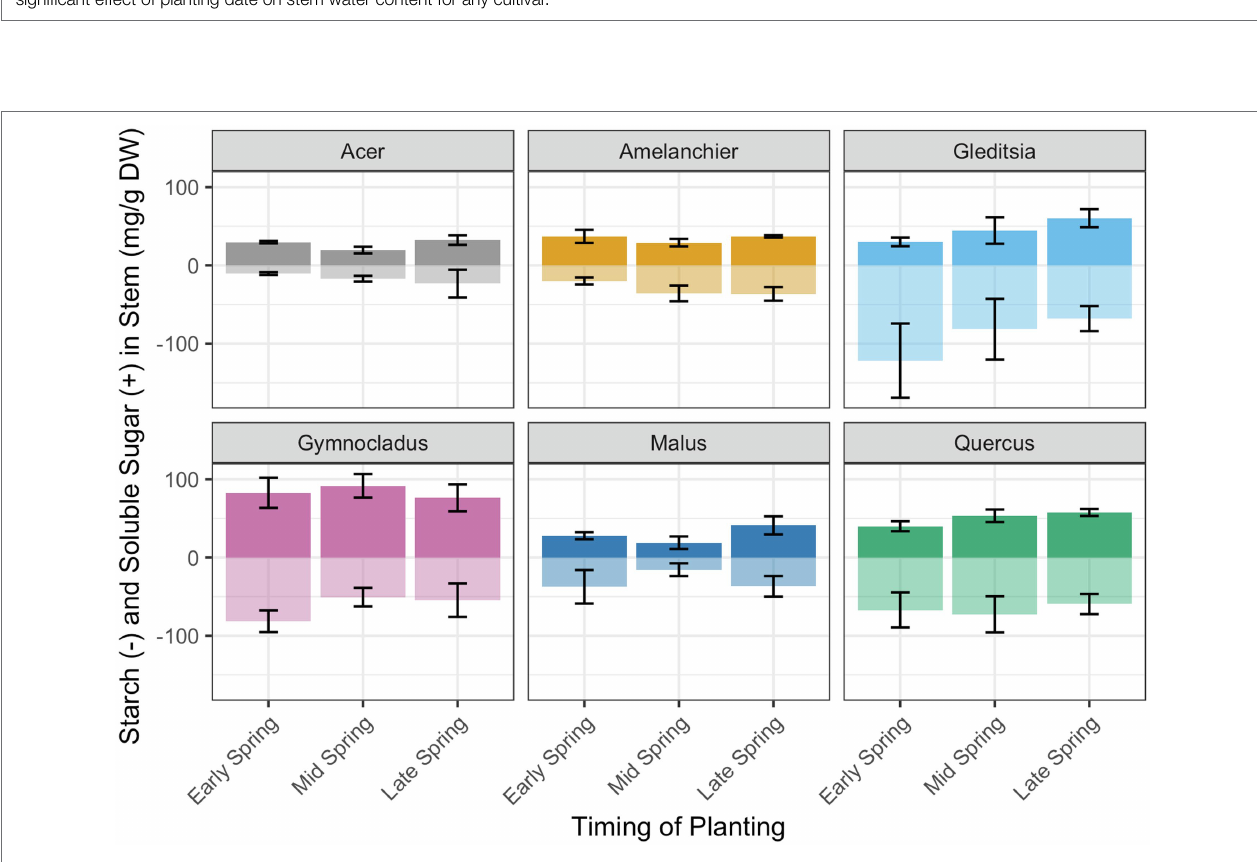
FIGURE 4 | Stem water content at the time of removal from cold storage and subsequent planting. Box plots show median, interquartile range, and minimum and maximum range for each week of planting. One outlier for Gleditsia has been removed in this figure, but not the statistical analysis. There was no evidence of a significant effect of planting date on stem water content for any cultivar.